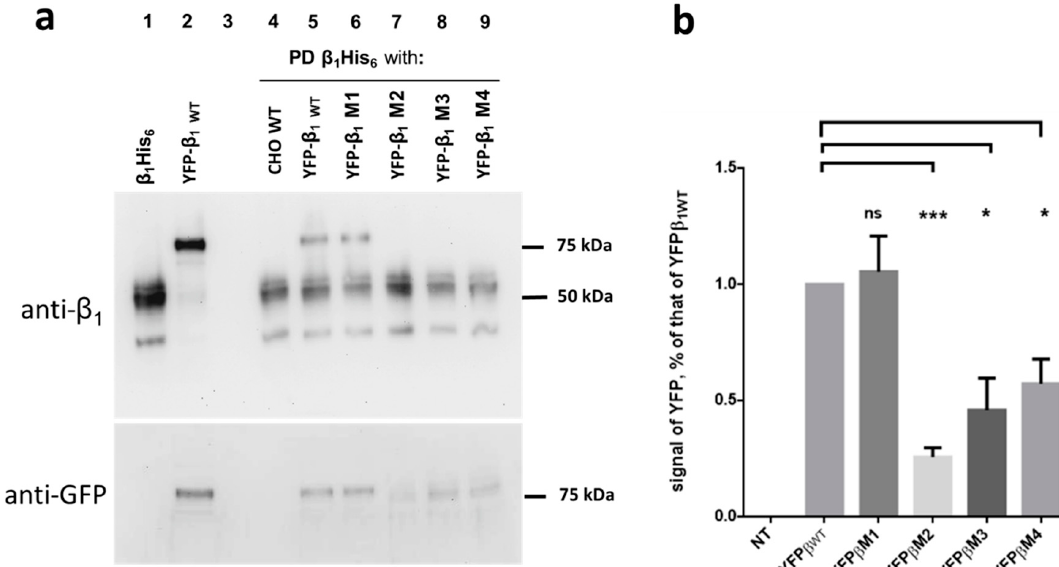
Figure 6. Mutants M2, M3, and M4 show decreased in vitro interaction with an immobilized His 6 -tagged β 1 subunit. ( a ) Upper panel: an anti- β 1 subunit antibody detects a ~ 50 KDa band in a lysate from cells stably expressing the Na + ,K + –ATPase β 1 subunit with a His 6 tag ( β 1 His 6 , lane 1). The same antibody recognizes a ~ 75KDa band in a cell lysate from fibroblasts stably expressing the fusion protein YFP- β 1 WT. After immobilizing the bait, β 1 His 6 protein as described in the Methods, total cell lysates from each of the following cell lines were loaded as prey proteins: non-transfected CHO WT cells (negative control) and CHO cells expressing YFP β 1 WT (positive control) or mutated YFP β 1 M1–M4. Eluates from each of the six protein-protein interactions were analyzed by western blot and detected with the same anti- β 1 subunit antibody as in Figure 5 (lanes 4 to 9). Lane 3 was intentionally left empty. A positive pull-down pattern corresponds to the mixture of both the immobilized and prey proteins (lane 5). In a negative pull-down only the immobilized protein was detected (lane 4). ( b ) Densitometric quantification of the pull-down results in A. The signal obtained by anti-GFP antibody in each of the eluted proteins was normalized with the signal of YFP β 1 WT and depicted as a comparative bar graph. Error bars SD ± (n = 3) *, significant difference p < 0.05; ***, significant difference p < 0.0005 and ns = non-significant, unpaired Student’s t -test with Welch correction.